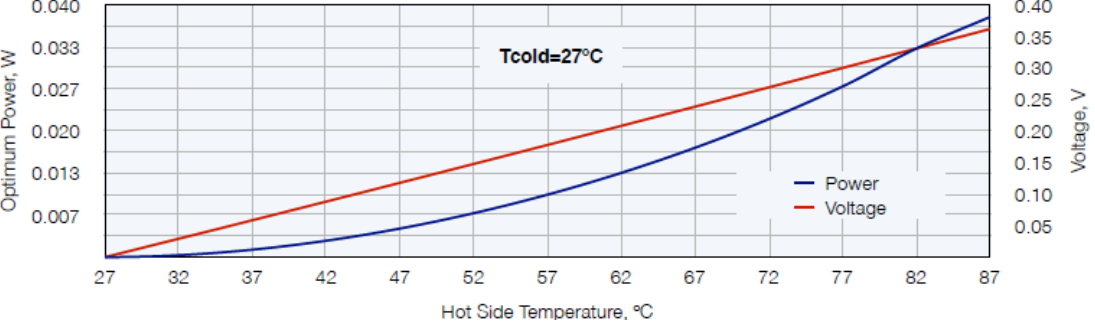
Figure 6. Output power of the thermoelectric generator.